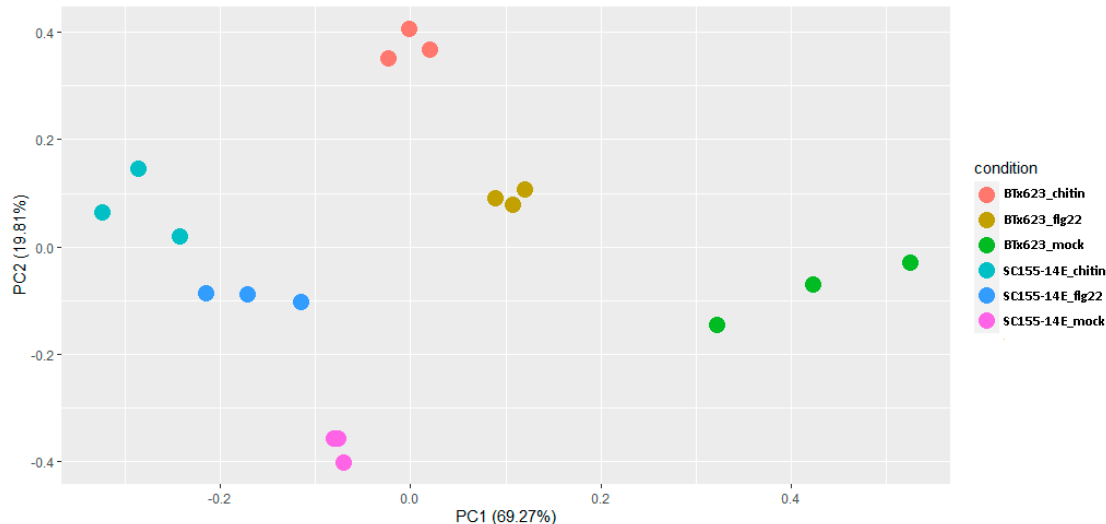
Figure 2. PCA plot of RNA-seq data of BTx623 and SC155-14E treated with flg22 or chitin as well as the mock-treatment. Sample plotting on the PC1 and PC2 showed the association between samples of three biological replicates of each sorghum line and each MAMP treatment. Each dot represents a condition after mapping from the original feature space (gene expression) to the first two principle components. Dots belong to the same condition tend to cluster together.